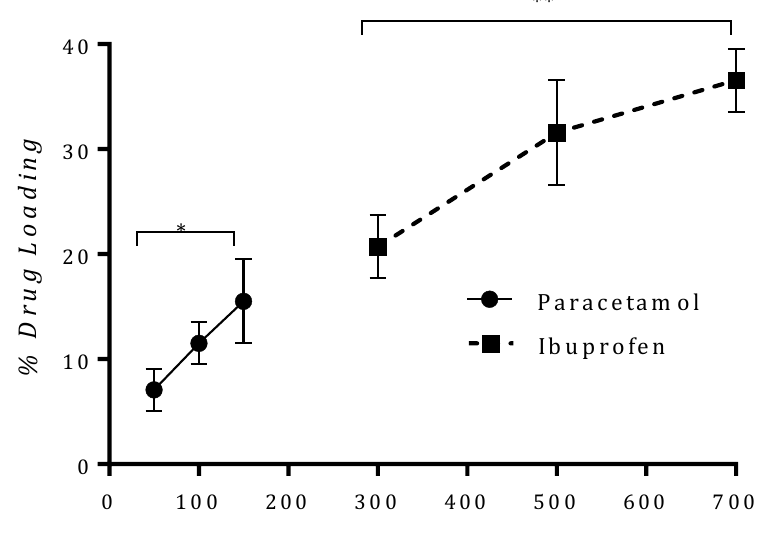
Figure 3. Effect of initial drug concentration on loading efficiency (stirring speed: 100 rpm; temperature: 20 ° C; solution volume: 5 mL; OLC dose: 500 mg; contact time: 1 hour). Results are the mean of triplicate experiments ± SD. Statistically significant differences are noted for p < 0.05 (* p < 0.05, ** p < 0.01, one-way ANOVA and Tukey’s multiple comparison test).